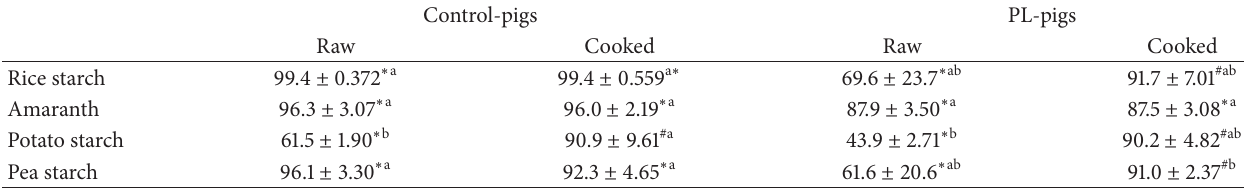
Table 3: PcD of starch (%) in control- and PL-pigs when starch of different botanical origin was used either raw or